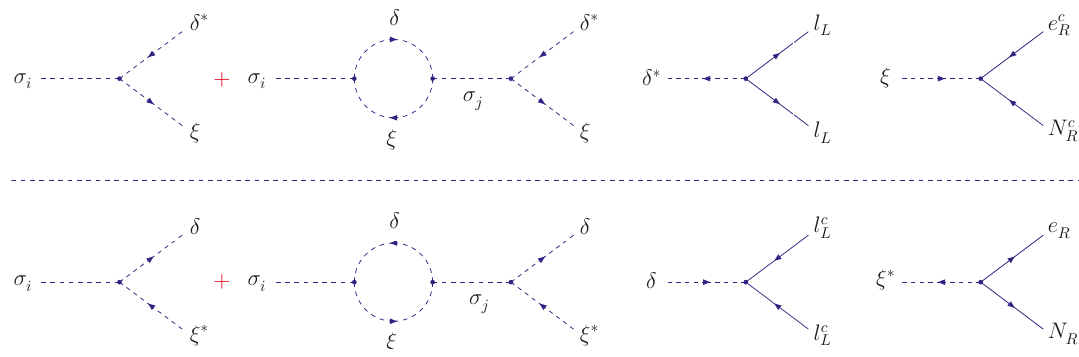
Figure 2 . The real scalars (cid:27) decay into the charged scalars (cid:14) and (cid:24) which subsequently decay into FIG. 2: The real scalars σ i decay into the charged scalars δ and ξ which subsequently decay into the SM leptons l L and e R as i the SM leptons l and e as well as the fermion singlets N well as the fermion singlets N R . L R while µ for the chemical potentials of the SM l,e,φ,N,δ,ξ leptons and Higgs scalar l , e , φ as well as the non- L R SM fields N , δ , ξ . The singly charged scalars δ and ξ as R well as the singlet fermions N are assumed near the TeV R scale. Therefore, above the TeV scale, the SM Yukawa interactions yield [28],